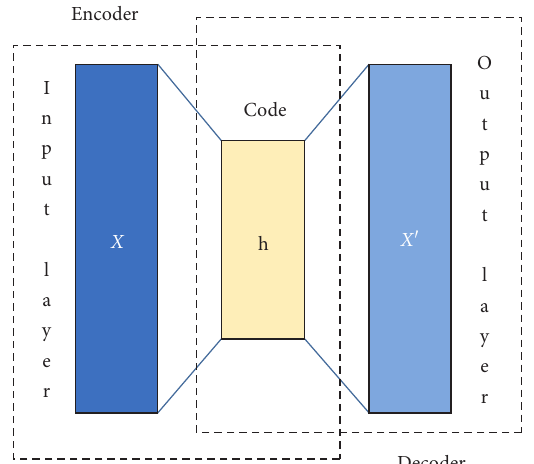
Figure 6: AE-based